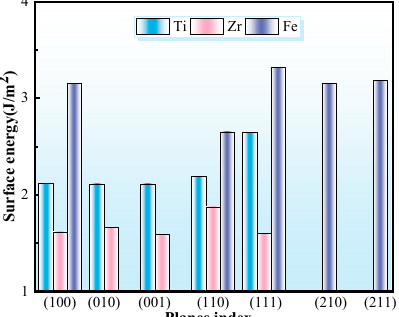
Figure 3. Surface energy of Fe, Ti, and Zr low index surfaces.